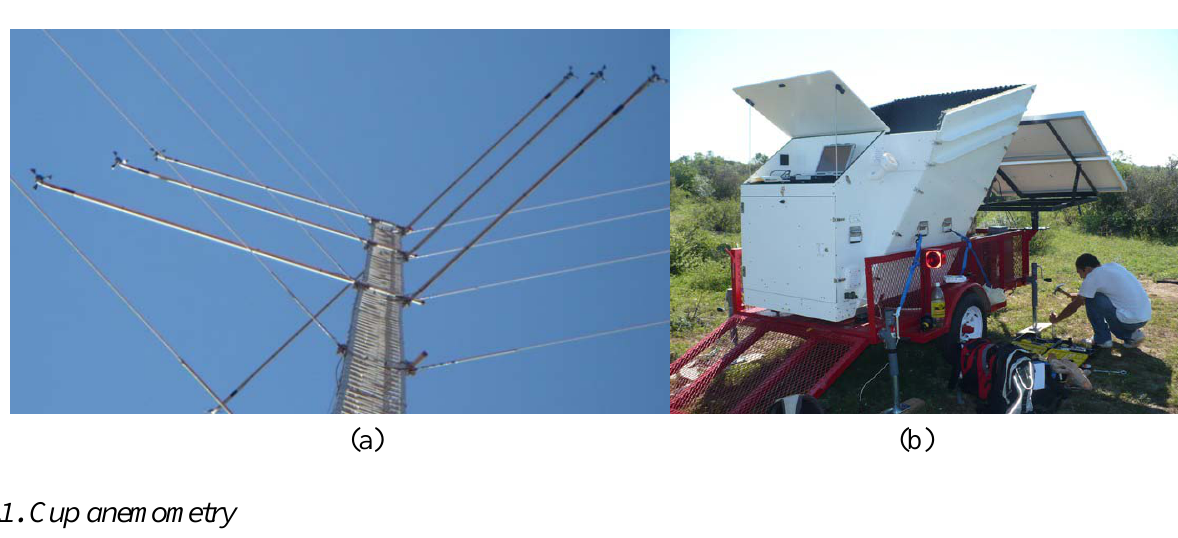
Figure 1. Photographs of (a) a tower-based measurement system with three redundant sets of cup anemometers at three heights, (b) a SODAR unit on a trailer and equipped with a photovoltaic power